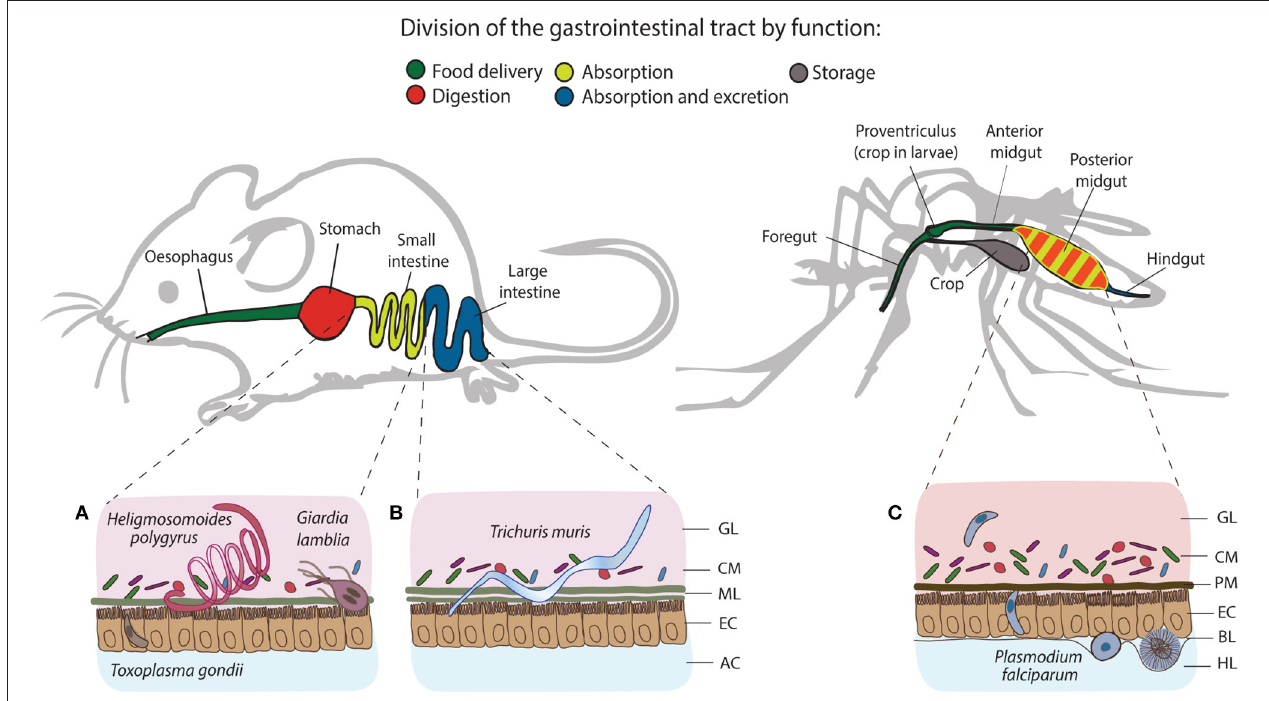
FIGURE 1 | Structural and functional differences of the gastrointestinal tracts of mice and mosquitoes, and the localization of their intestinal parasites. The gastrointestinal tract of mice consists of esophagus, stomach, small and large intestine, and colon, whereas in mosquitoes, it comprises the foregut, diverticulum (crop), midgut (anterior and posterior) and hindgut. One of the differences between gut organization is the separation of the food digestive and nutrient absorption functions taking place in the stomach and the small intestine of mice. In mosquitoes, digestion and absorption occur in the same organ, the midgut. The tracts secrete a protective layer that serves as a mechanical barrier against the acidic gastric environment and diverse pathogens. In mammals, epithelial goblet cells dispersed throughout the epithelium produce a viscous mucus layer that covers the entire tract, except the large intestine, which is characterized by a double mucus layer. Similarly to mucus, mosquitoes secrete the peritrophic matrix (PM), a semi-permeable extracellular structure composed of chitin and glycoproteins. In larvae, the PM is secreted continuously by a specialized organ cardia located in the anterior midgut, whereas in adult females, it is believed to be secreted by the midgut epithelial cells only after blood feeding. Small (A) and large (B) intestines of mice harbor a series of gastrointestinal parasites: Toxoplasma exploits the small intestine for the establishment of the infection; Giardia and adult Heligmosomoides polygyrus worms thrive in the lumen of the small intestine, while adults of Trichuris muris anchor to the epithelial cells of the large intestine. In mosquitoes, Plasmodium invades the posterior midgut to establish extracellular infection at the basal side of the epithelial cells (C) . GL, gut lumen; CM, complex microbiota; ML, mucus layer; EC, epithelial cells; AC, abdominal cavity; PM, peritrophic matrix; BL, basal lamina; HL,